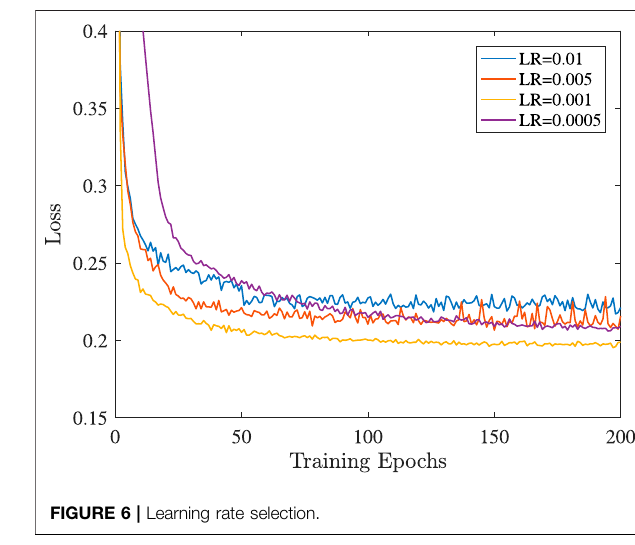
FIGURE 4 | Average convergence time versus q 1